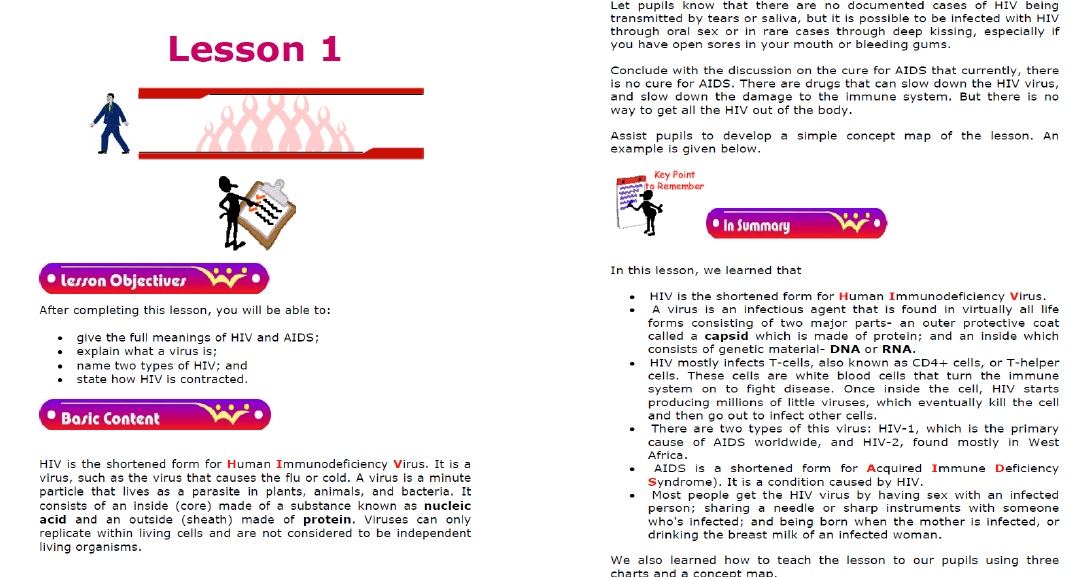
Figure 1 . VIHEAF online lesson (source: